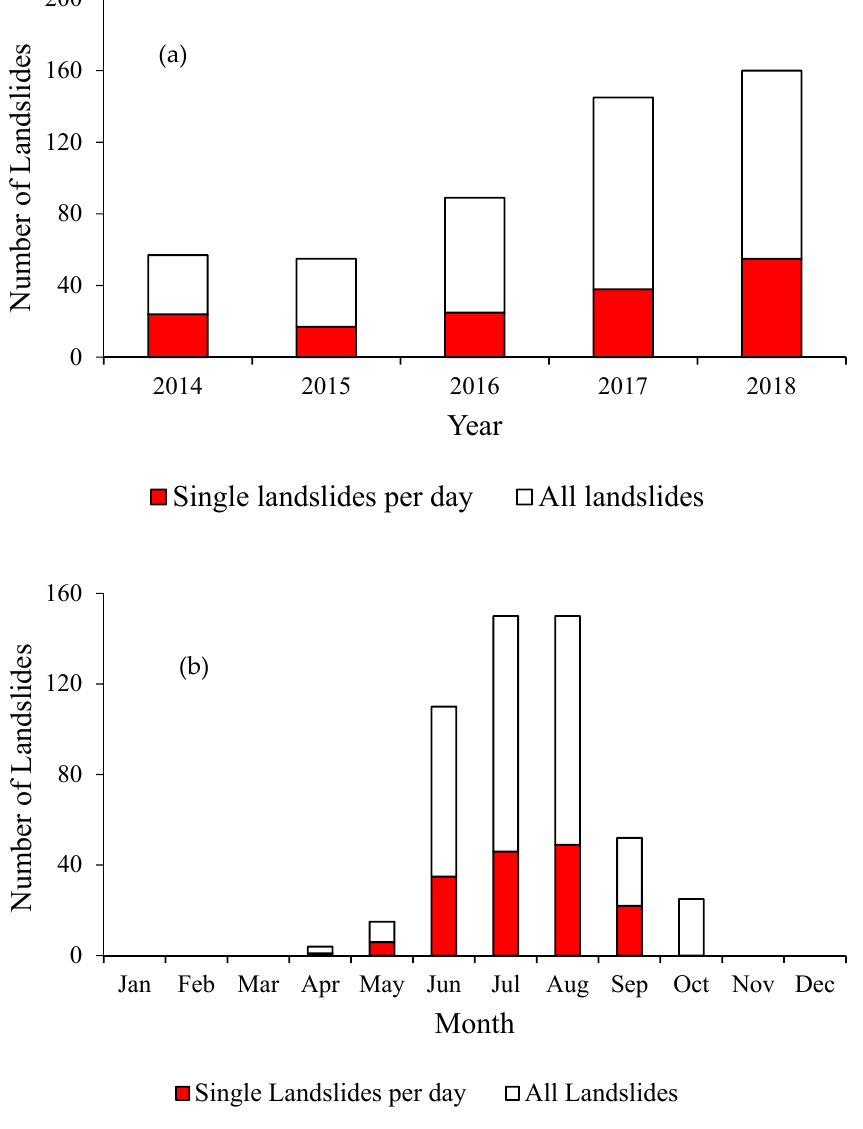
Figure 3. Number of landslides ( a ) per year and ( b ) per month between 2014 and 2018.